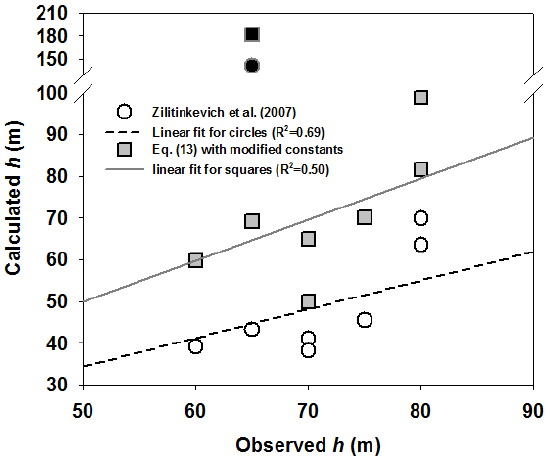
Figure 11. Comparison of observed NBL heights ( h ) with calculated NBL height. Calculated h was obtained from Eq. (12) with CR=0.6, CCN=1.36, CNS=0.51 (white circles) recommended by Zilitinkevich et al. (2007) and CR=0.6, CCN=1.25, CNS=0.9 (gray squares) modified in this study. Black short-dashed line represents the best linear fits for white circles with the slope of 0.69 (R 2 =0.67) and gray solid line for gray squares with the slope of 0.99 (R 2 =0.50). Black square and circle were not included in linear fit calculations.